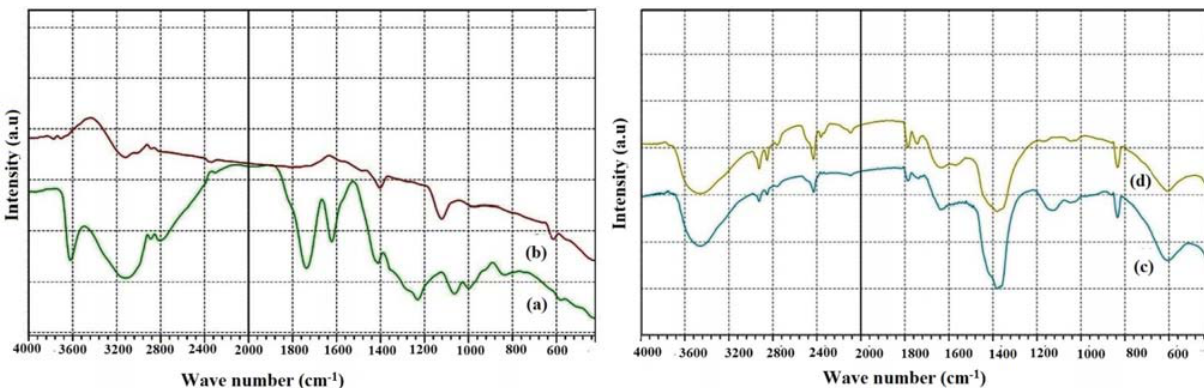
Figure 4. FT-IR spectra of (a) GO (b) NG (c) NiFe